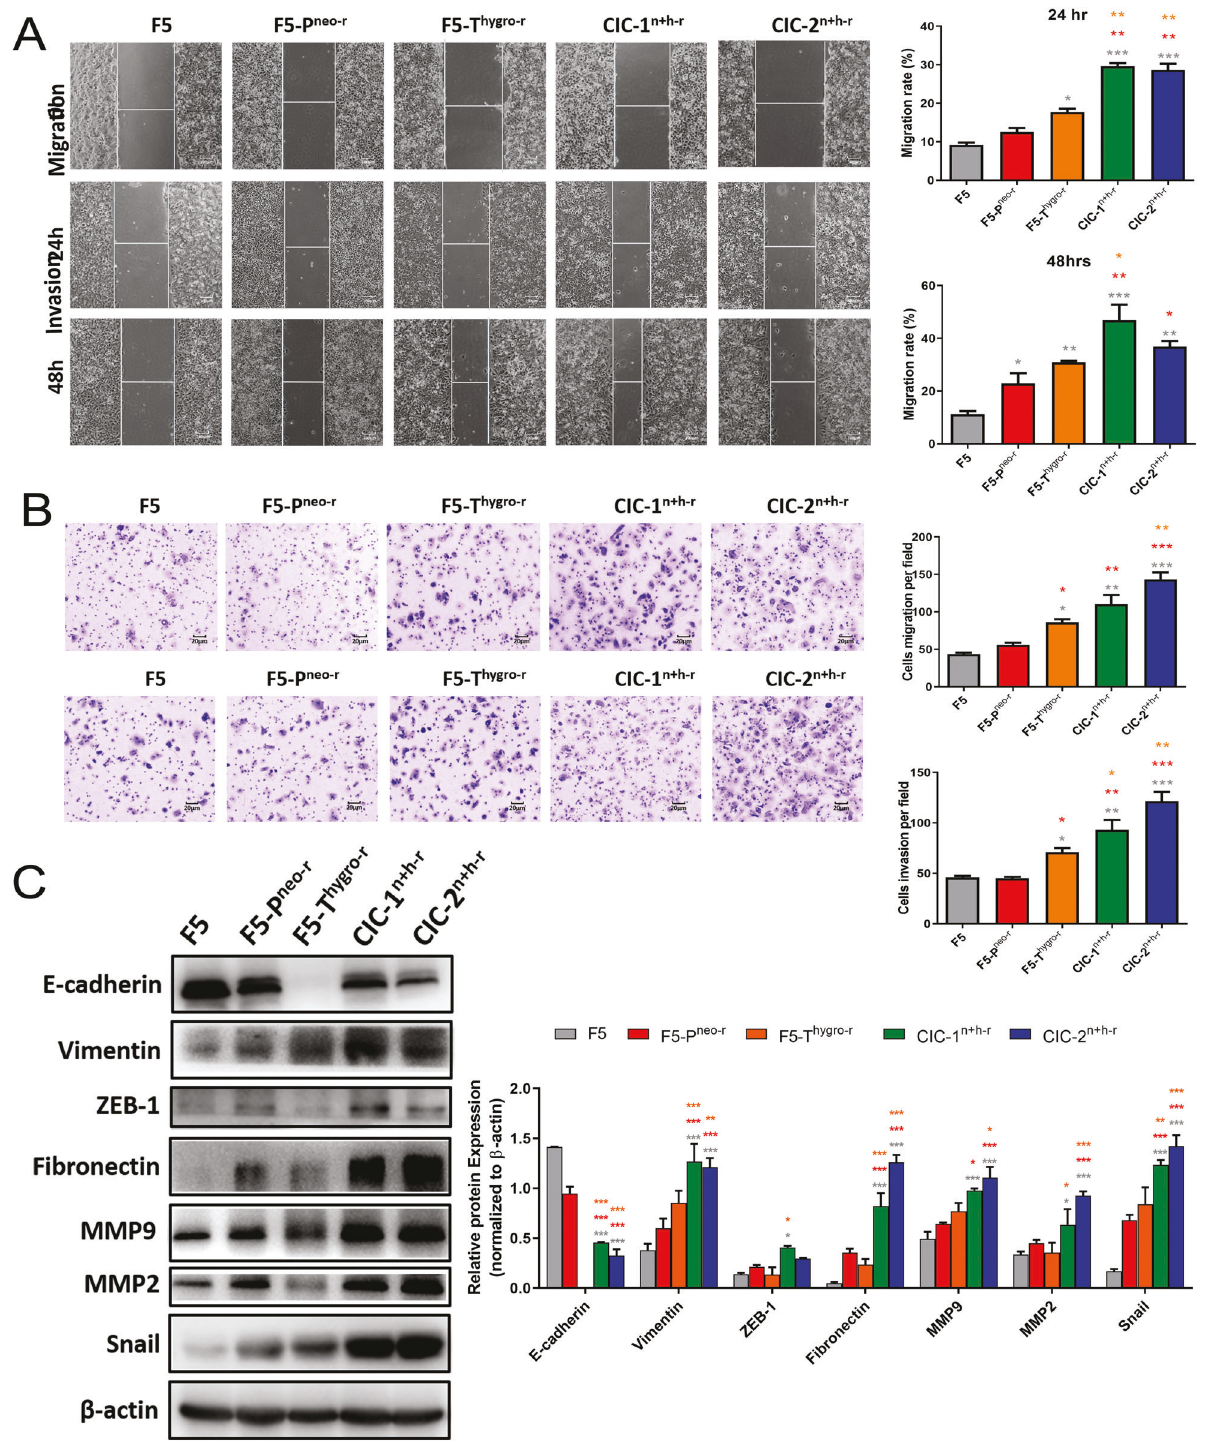
Fig. 4 The dual-antibiotic-resistant CIC derivative cells exhibited more metastatic potential. A Representative images of wound healing of F5, F5-P neo-r , F5-T hygro-r , CIC-1 n + h-r and CIC-2 n + h-r cells. Histograms depict the average migrated distance. B Detecting the migration (upper panel) and invasion (lower panel) ability of F5, F5-P neo-r , F5-T hygro-r CIC-1 n + h-r and CIC-2 n + h-r cells. Four randomly selected fi elds were captured and quantitation was presented in the graph. Representative micrographs are also shown (200 × magni fi cation). C The expression of E- cadherin, Vimentin, ZEB-1, Fibronectin, MMP9, MMP2, Snail and GAPDH was used as control in F5, F5-P neo-r , F5-T hygro-r , CIC-1 n + h-r and CIC-2 n + h-r cells by Western blot analysis(left). The bands of proteins were quanti fi ed by densitometry and normalized to β -actin protein (right). All data are showed as the mean ± S.D. of three independent experiments, * P < 0.05, ** P < 0.01, *** P < 0.001 * P < 0.05, ** P < 0.01, *** P < 0.001.